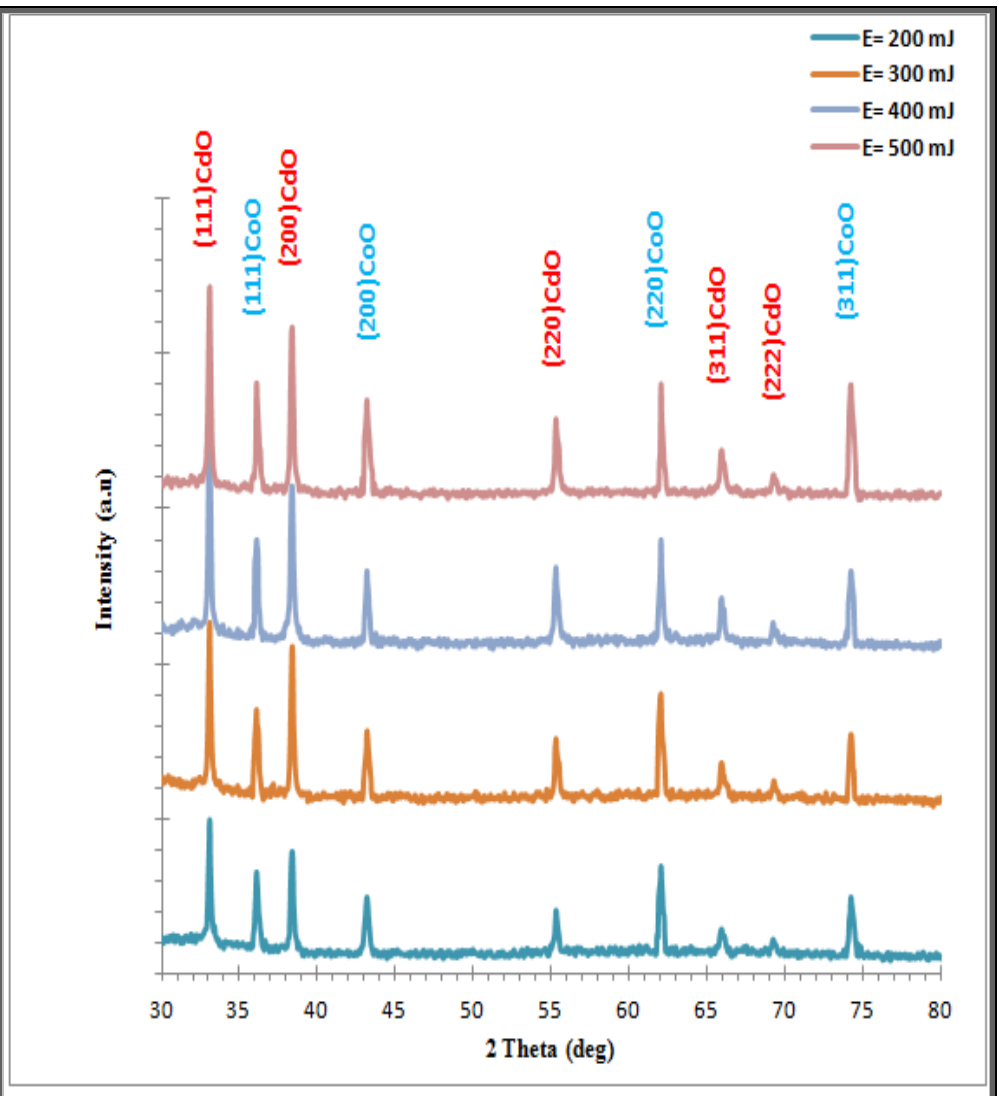
Fig. 2: XRD pattern for CdO:CoO thin films prepared with different laser